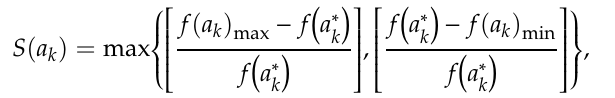
Table 1. The structure parameters combination set for sensitivity analysis.